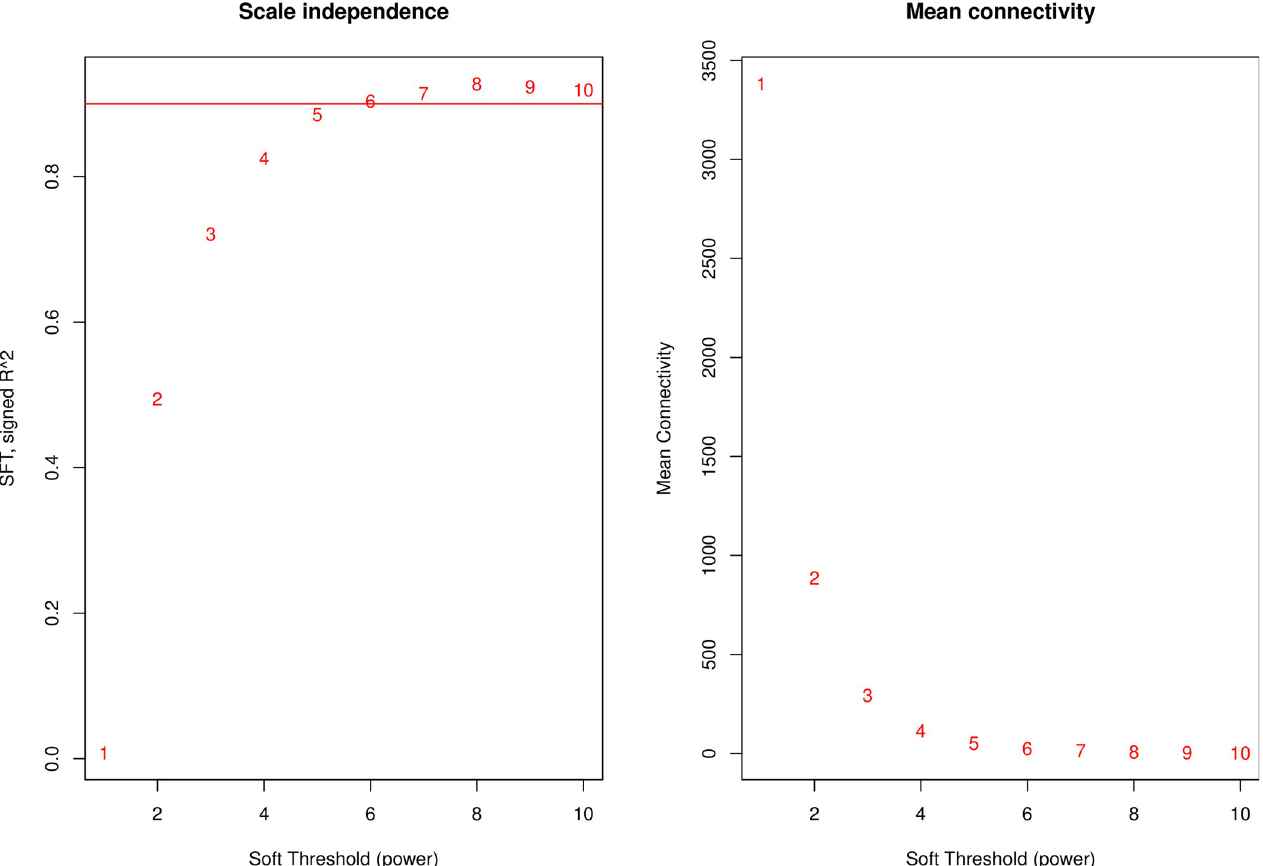
Fig 2. Network topology analysis for various soft thresholds. The left panel shows the scale-free fit index (y-axis) as a function of the soft threshold value (x- axis); the right panel shows the average connectivity (y-axis) as a function of the soft threshold value (x-axis).